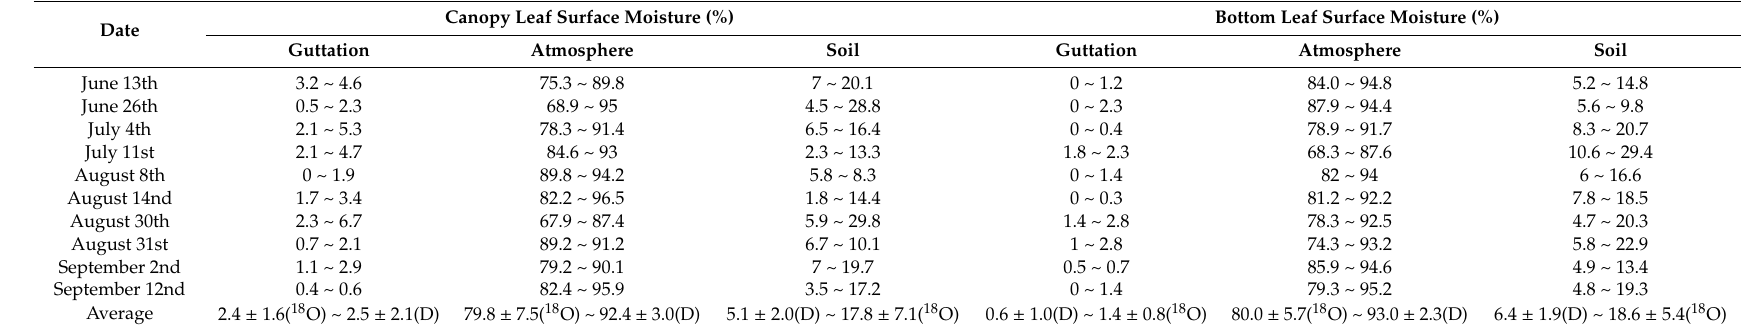
Table 2. Leaf surface moisture sources of B. sinica in Changchun in